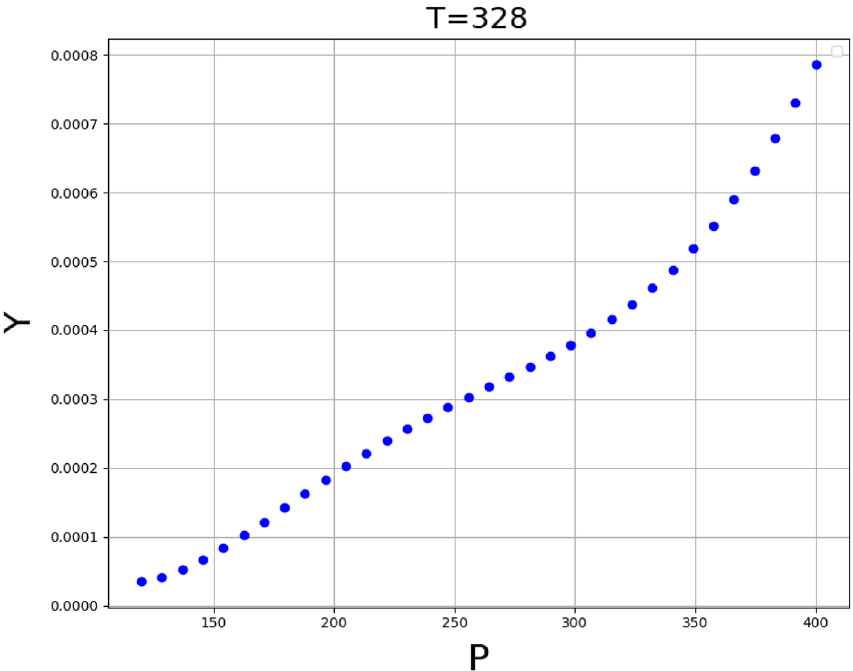
Figure 6. Trend of variable P (pressure, bar) calculated using GPR model (Y: solubility, mole fraction).